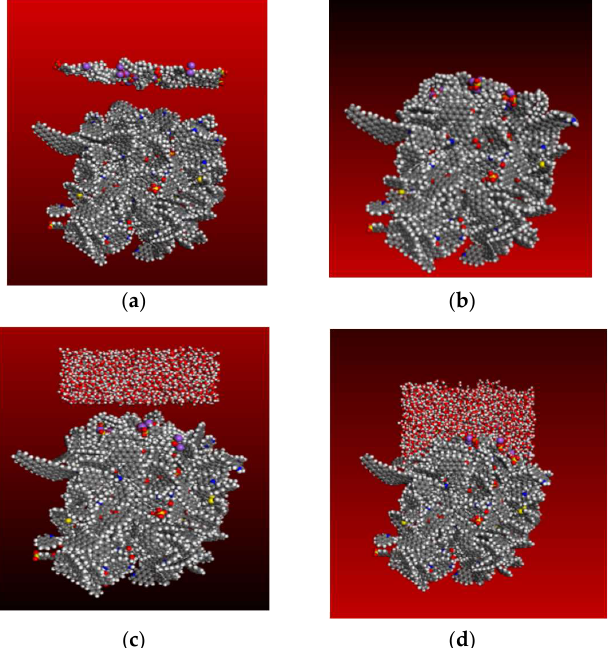
Figure 2. MD simulation process: ( a ) initial conformation in the first stage; ( b ) equilibrium conformation in the first stage; ( c ) initial conformation in the second stage; ( d ) equilibrium conformation in the second stage.